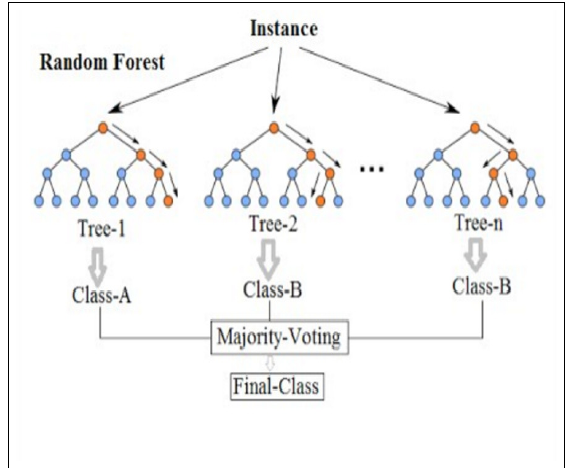
Figure 3. Random Forest [7] 4.4.2 XGBoost